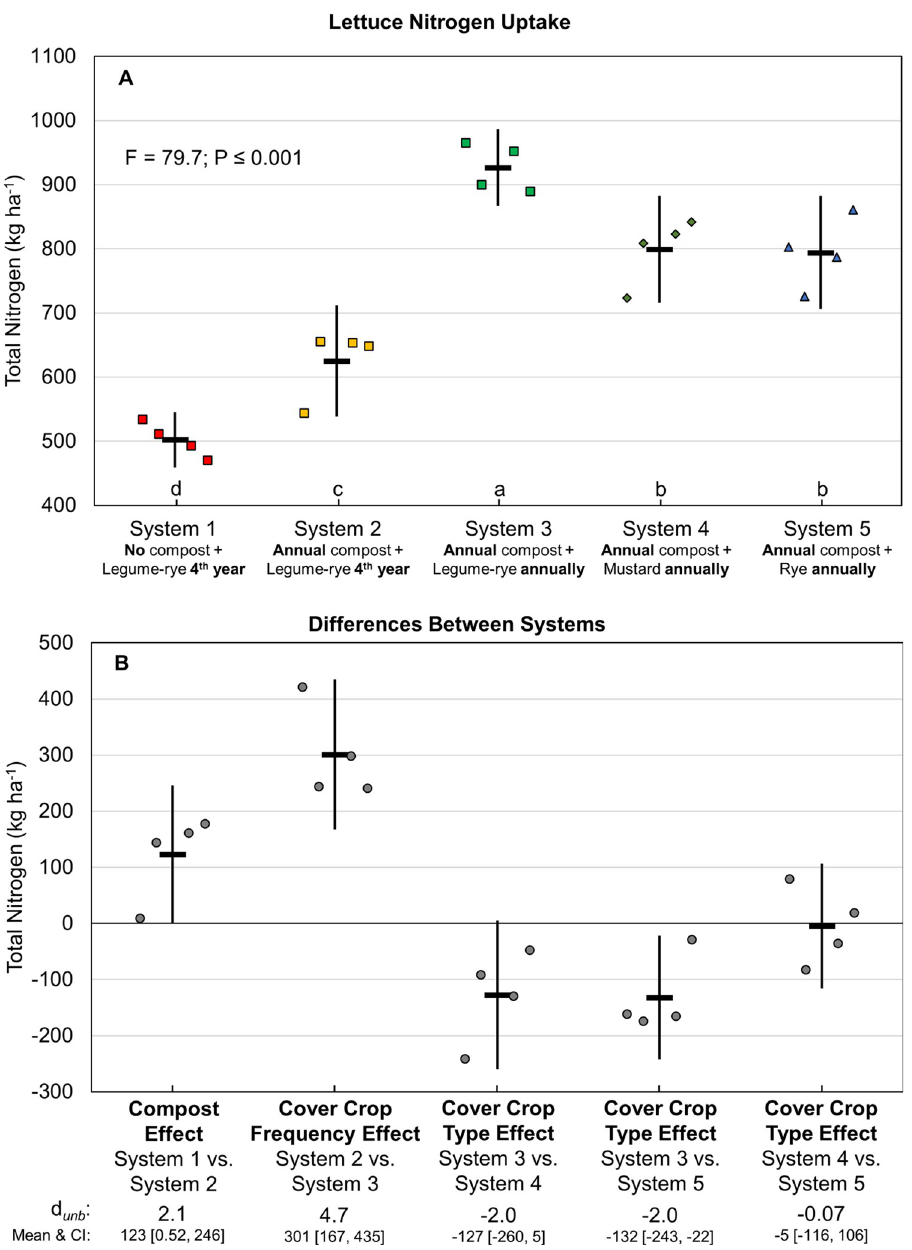
Fig 6. Cumulative above ground and estimated below ground lettuce nitrogen uptake over eight years of vegetable production. Mean nitrogen uptake (A) and mean paired differences between systems (B) in 5 organic vegetable systems. Systems differed by annual compost additions, cover crop type and cover cropping frequency. Error bars are 95% confidence intervals (CI) around the mean (horizontal line). Data points are replicates 1 through 4 averaged across years and are clustered around the mean left to right so as not to obscure the mean and CI. Different lower-case letters above the x-axis in plot A indicate that means are significantly different based on the Tukey-Kramer adjusted family-wise error rate of P � 0.05. The standardized effect size (Cohen’s unbiased d , d ) is shown below the x-axis in unb plot.